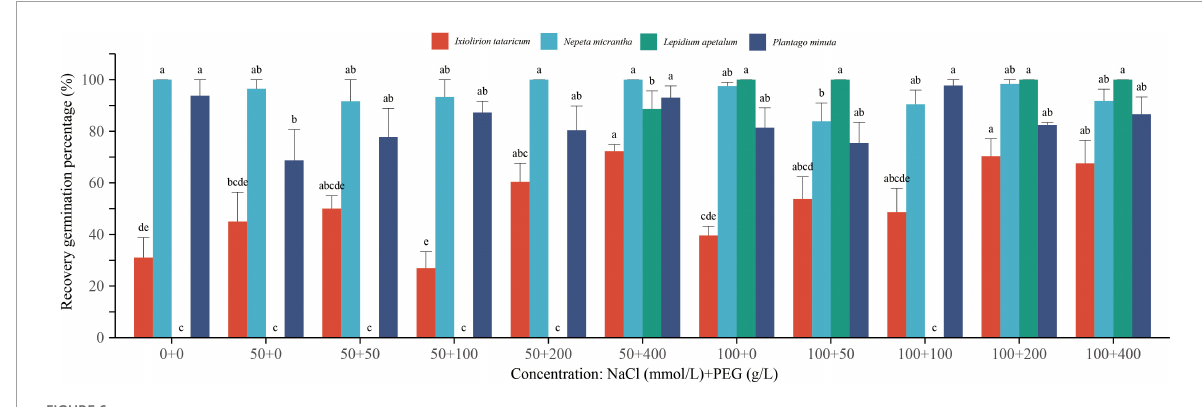
FIGURE6 Effects of coupled salt-drought on the recovery germination percentage of Ixiolirion tataricum , Nepeta micrantha , Lepidium apetalum , and Plantago minuta seeds. Different lowercase letters in the figure indicated significant differences among different concentrations of the same species ( P <